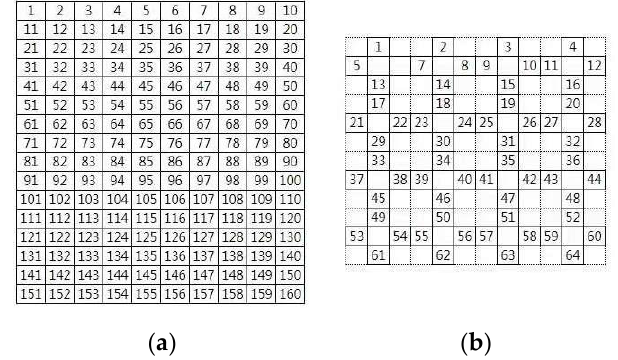
Figure 3. Spatial distribution of Kitronyx tactile sensing array ( a ) and spatial distribution of self-made tactile sensing array ( b ).